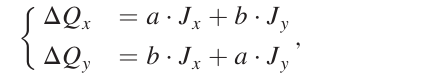
FIG. 5. Separation between the beams normalized to the beam size of Beam 1 at the location of the long range beam-beam interactions in the common chamber around IP5 at the end of the betatron squeeze (blue) and in collision